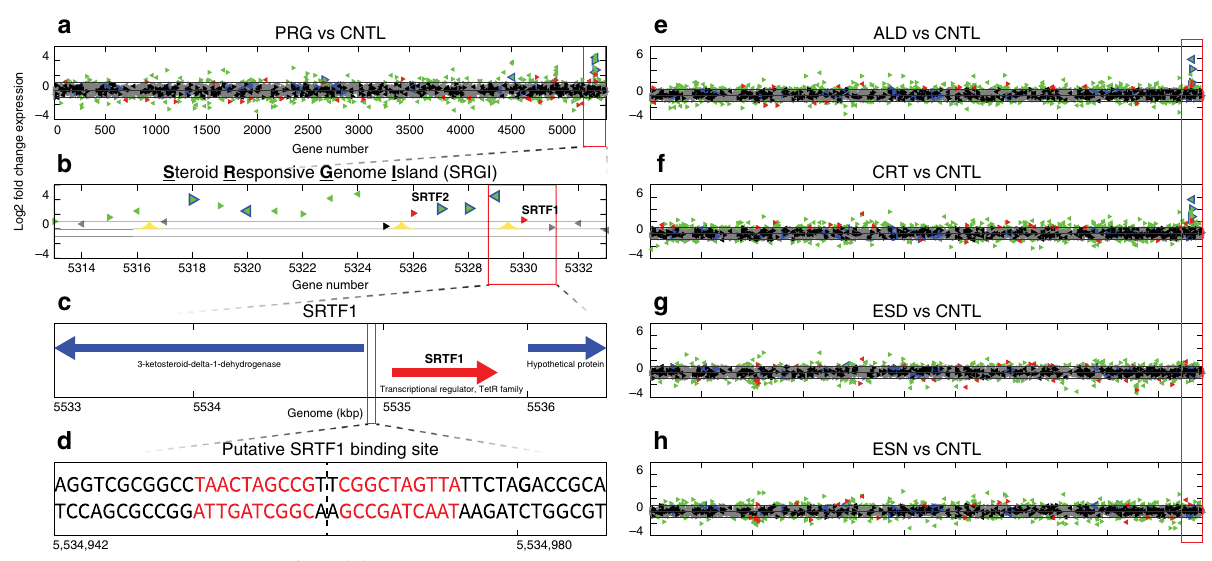
Fig. 1 Screening of P. simplex for steroid sensing aTFs. a – e Log2-fold change expression in response to each hormone relative to control. Each triangle is a gene (red = differentially expressed TF, black = non-differentially expressed TF, blue = gene with annotated sterol related function, green = differentially expressed other gene, gray = non-differentially expressed other gene). The Steroid Responsive Gene Island (SRGI) that is differentially expressed in response to PRG, ALD, and CRT is boxed in red. SRTF1 and SRTF2 are two steroid responsive TFs. f Zoomed in view of SRGI. Yellow peaks are experimentally validated binding sites for SRTF1. g SRGI region around SRTF1. h SRTF1 palindromic binding site upstream of SRTF1 gene. RNA-seq data are deposited in the Gene Expression Omnibus with accession number GSE141603.